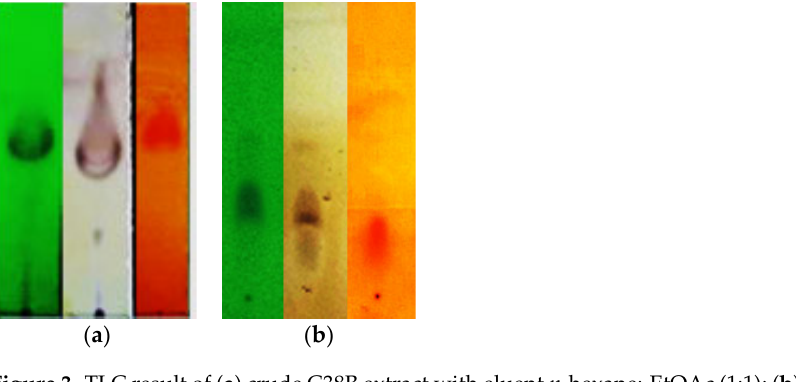
Figure 3. TLC result of ( a ) crude C38B extract with eluent n ‐ hexane: EtOAc (1:1); ( b ) active C38BK2FA fraction with eluent n ‐ hexane: DCM (10:1).